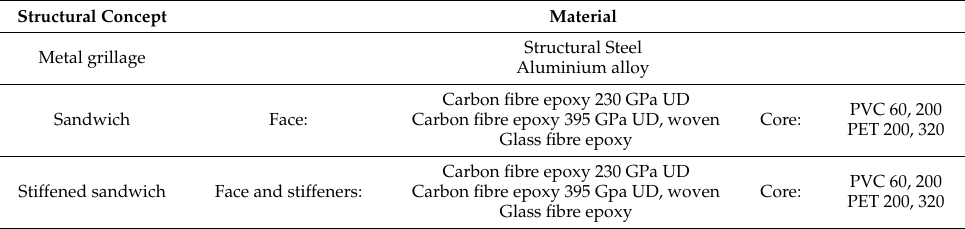
Table 1. Structural concepts and respective materials that are investigated in this study.